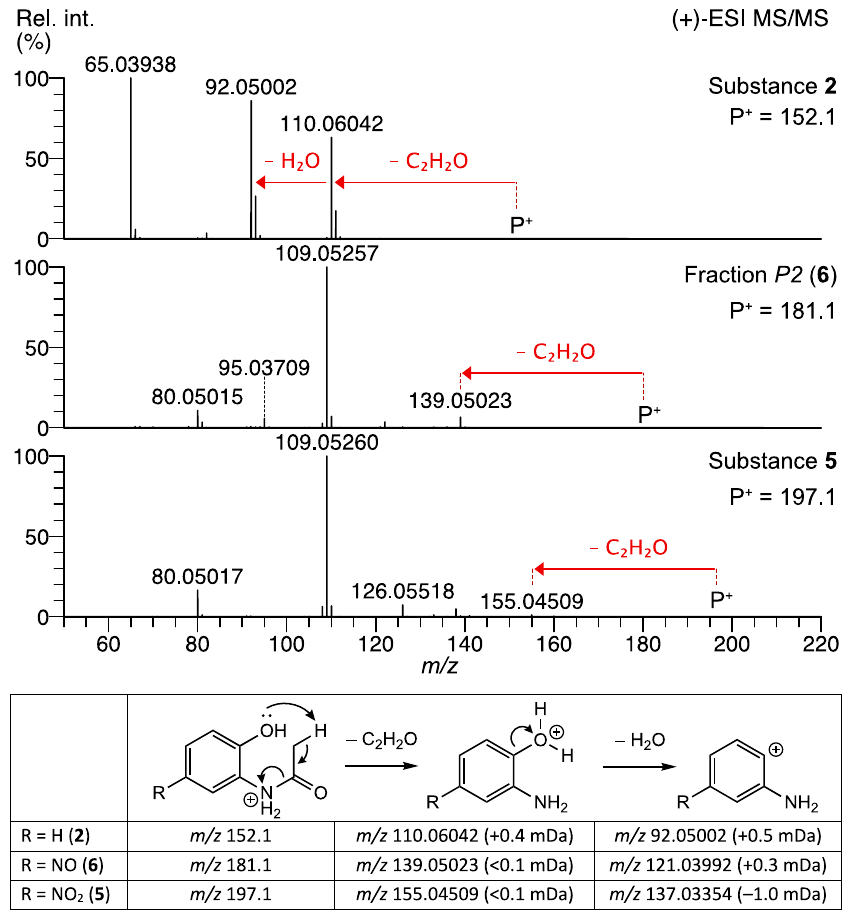
Figure 3. (+)-ESI-MS/MS spectra of N -(2-hydroxy-5-nitrosophenyl)acetamide ( 6 ) from fraction P2 of extract F49 produced by A. aminovorans (middle) in comparison with the commercially available compounds 2 (top) and 5 (bottom).